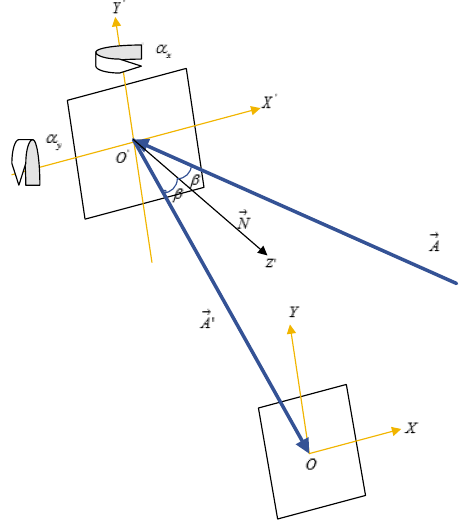
Figure 1. Cartesian coordinate system based on MEMS micromirror scanning.